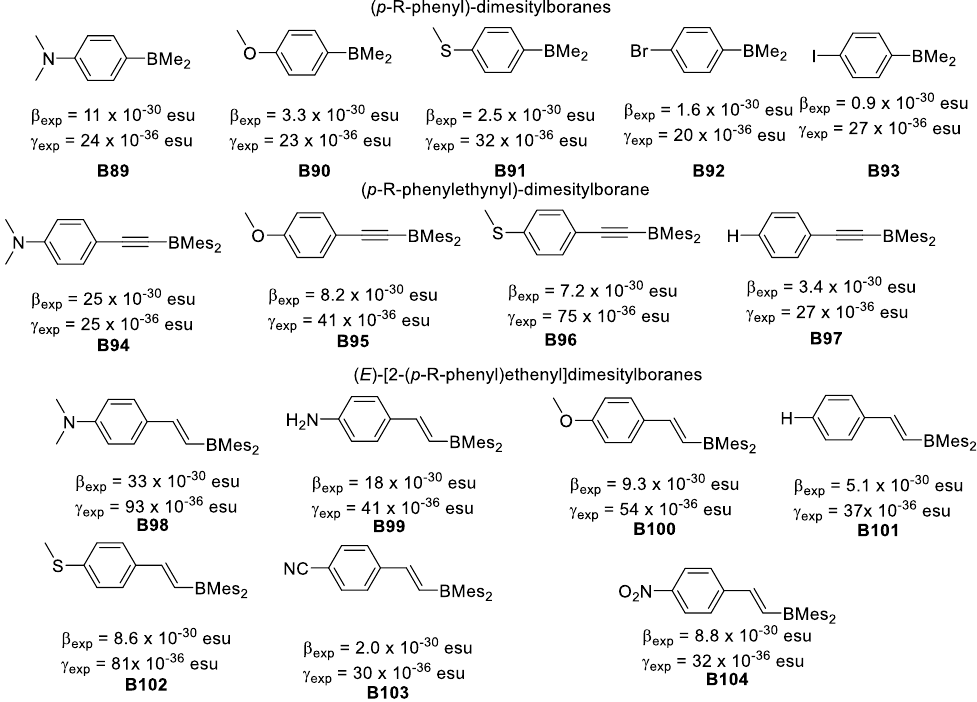
Figure 32. First and second order hyperpolarizabilities of conjugated dimesitylboranes.